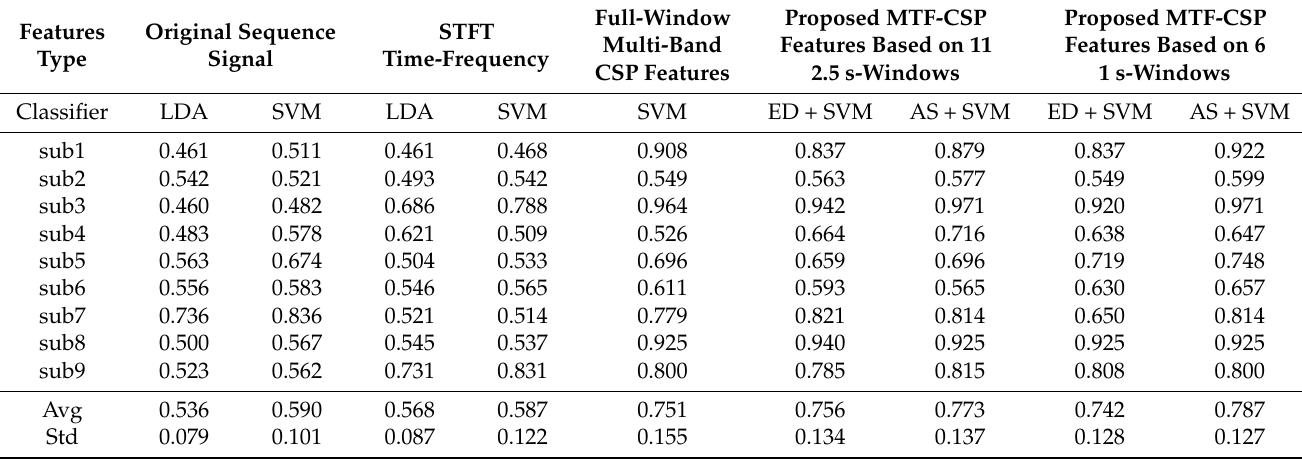
Table 4. Comparison of classification accuracy of original timing signals, time–frequency features, and MTF-CSP features.